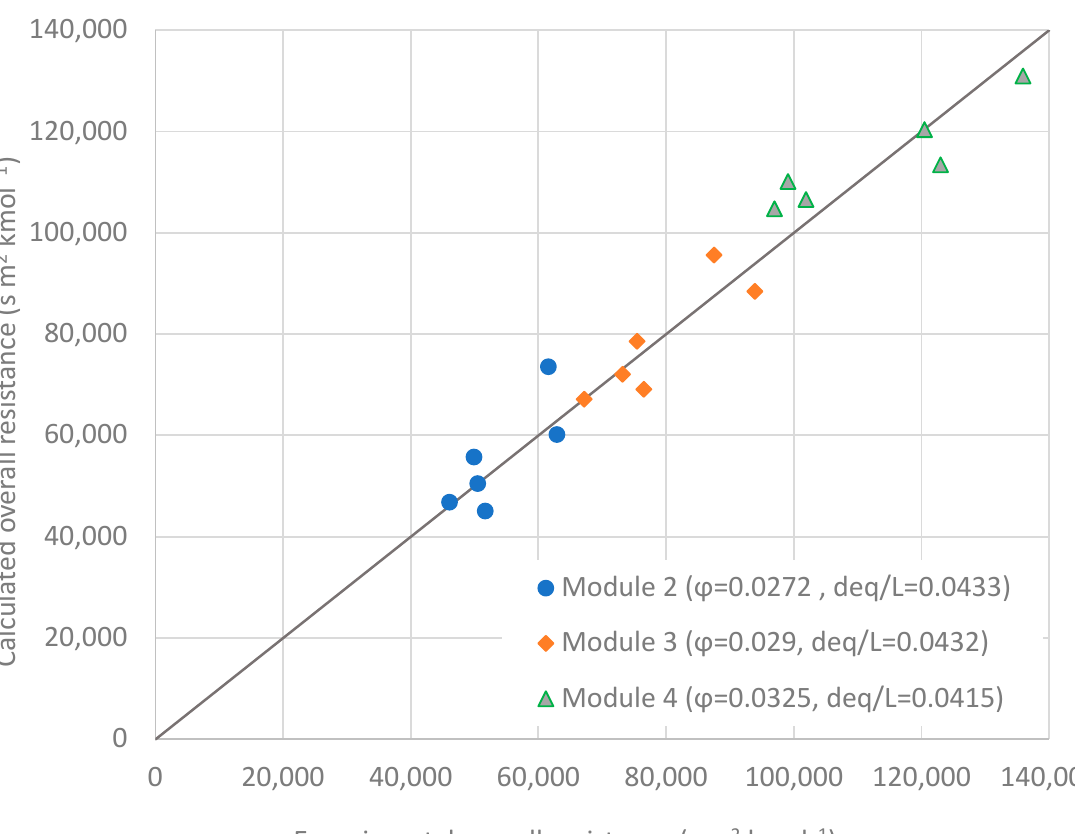
Figure 3. Parity graph of simulated overall resistances vs. experimental overall resistances for butanol permeation. Values were obtained and calculated for three modules at different flow rates.